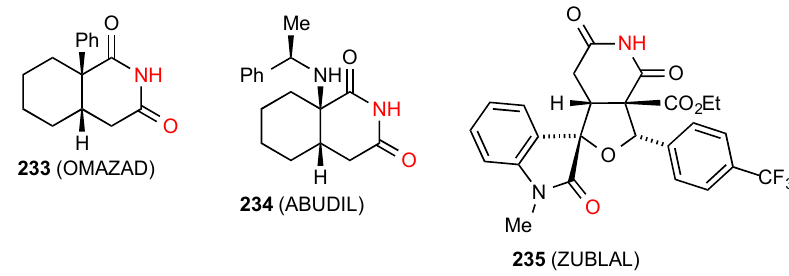
Figure 70. Ring-fused glutarimides showing patterns A , B and F.